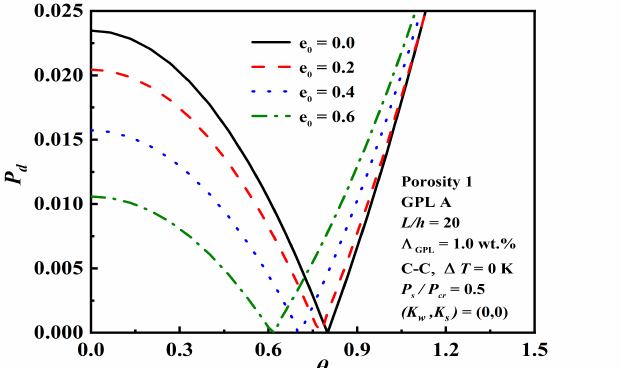
Figure 13. Effect of the porosity coefficient e 0 on dynamic instability.